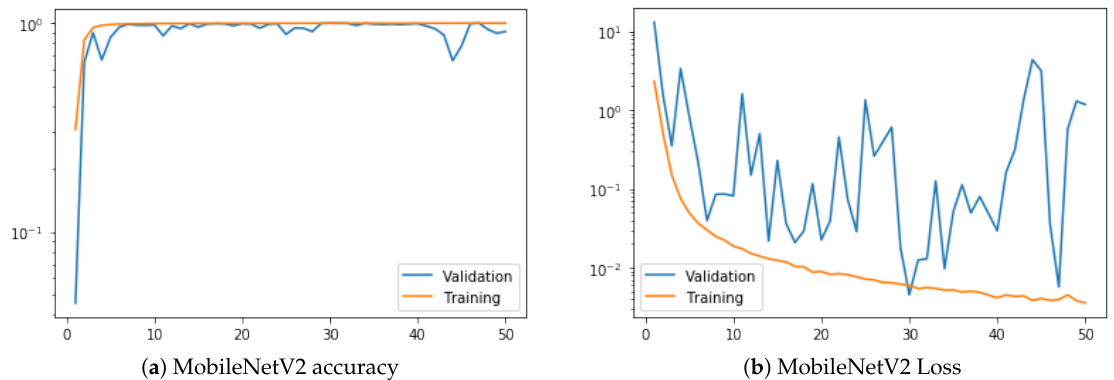
Figure A2. Loss and accuracy metrics of the MobileNetV2 model (with halved filters in each layer) during the training. The metrics of the data with which the model is fitted (training) are shown in orange while the blue graph shows the plots of the validation set, used as a guide to adjust the hyperparameters of the model. The metrics indicate that the model achieves high accuracy in that is too complex for our training dataset, leading it to overfitting.